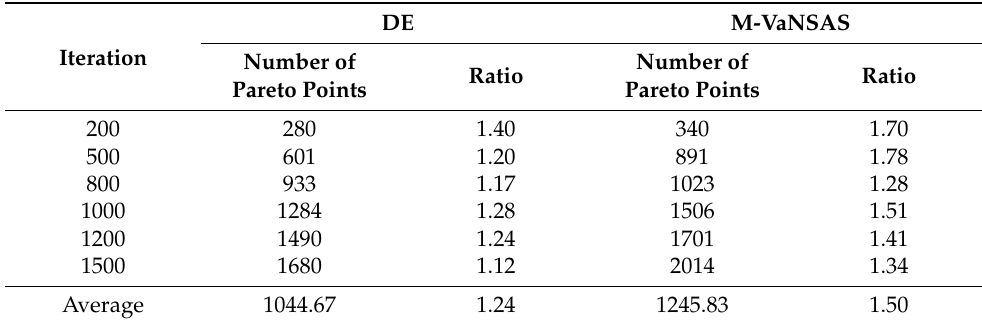
Table 6. Comparing the Pareto ratio of DE and M-VaNSAS.